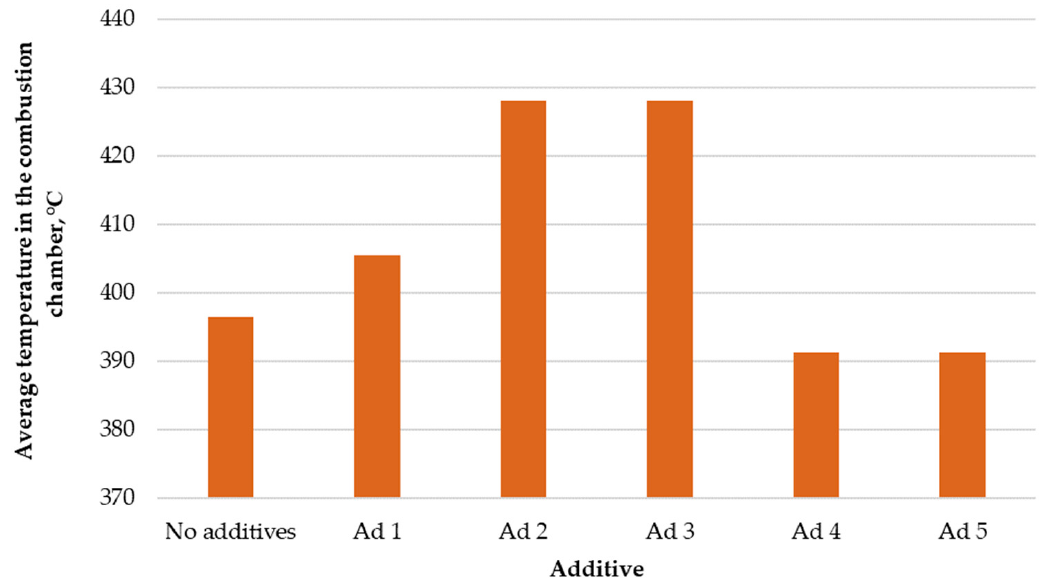
Figure 2. Comparison of average temperatures in the low-power biomass boiler’s combustion chamber.